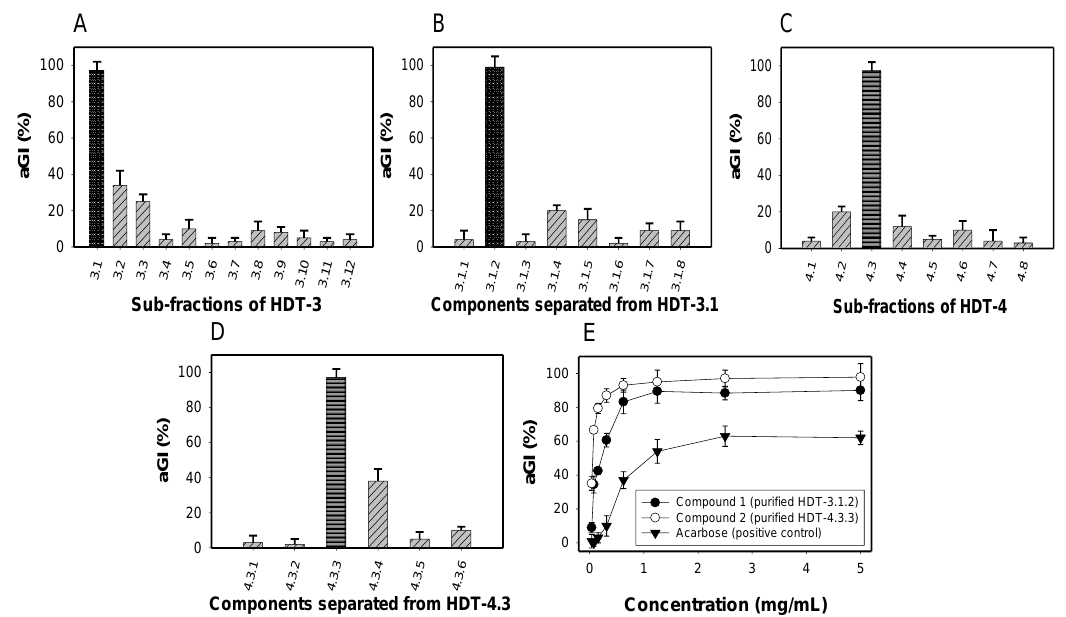
Figure 4. Inhibitory activity (%) of sub-fractions of HDT-3 ( A ) and HDT-4 ( C ) after separation by silica opened column (first time). aGI (%) of components of HDT-31 ( B ) and HDT-4.3 ( D ) after further separation by silica open column (second time). aGI (%) of isolated compounds and acarbose ( E ). Results are means ± SD of multi tests (n = 3).